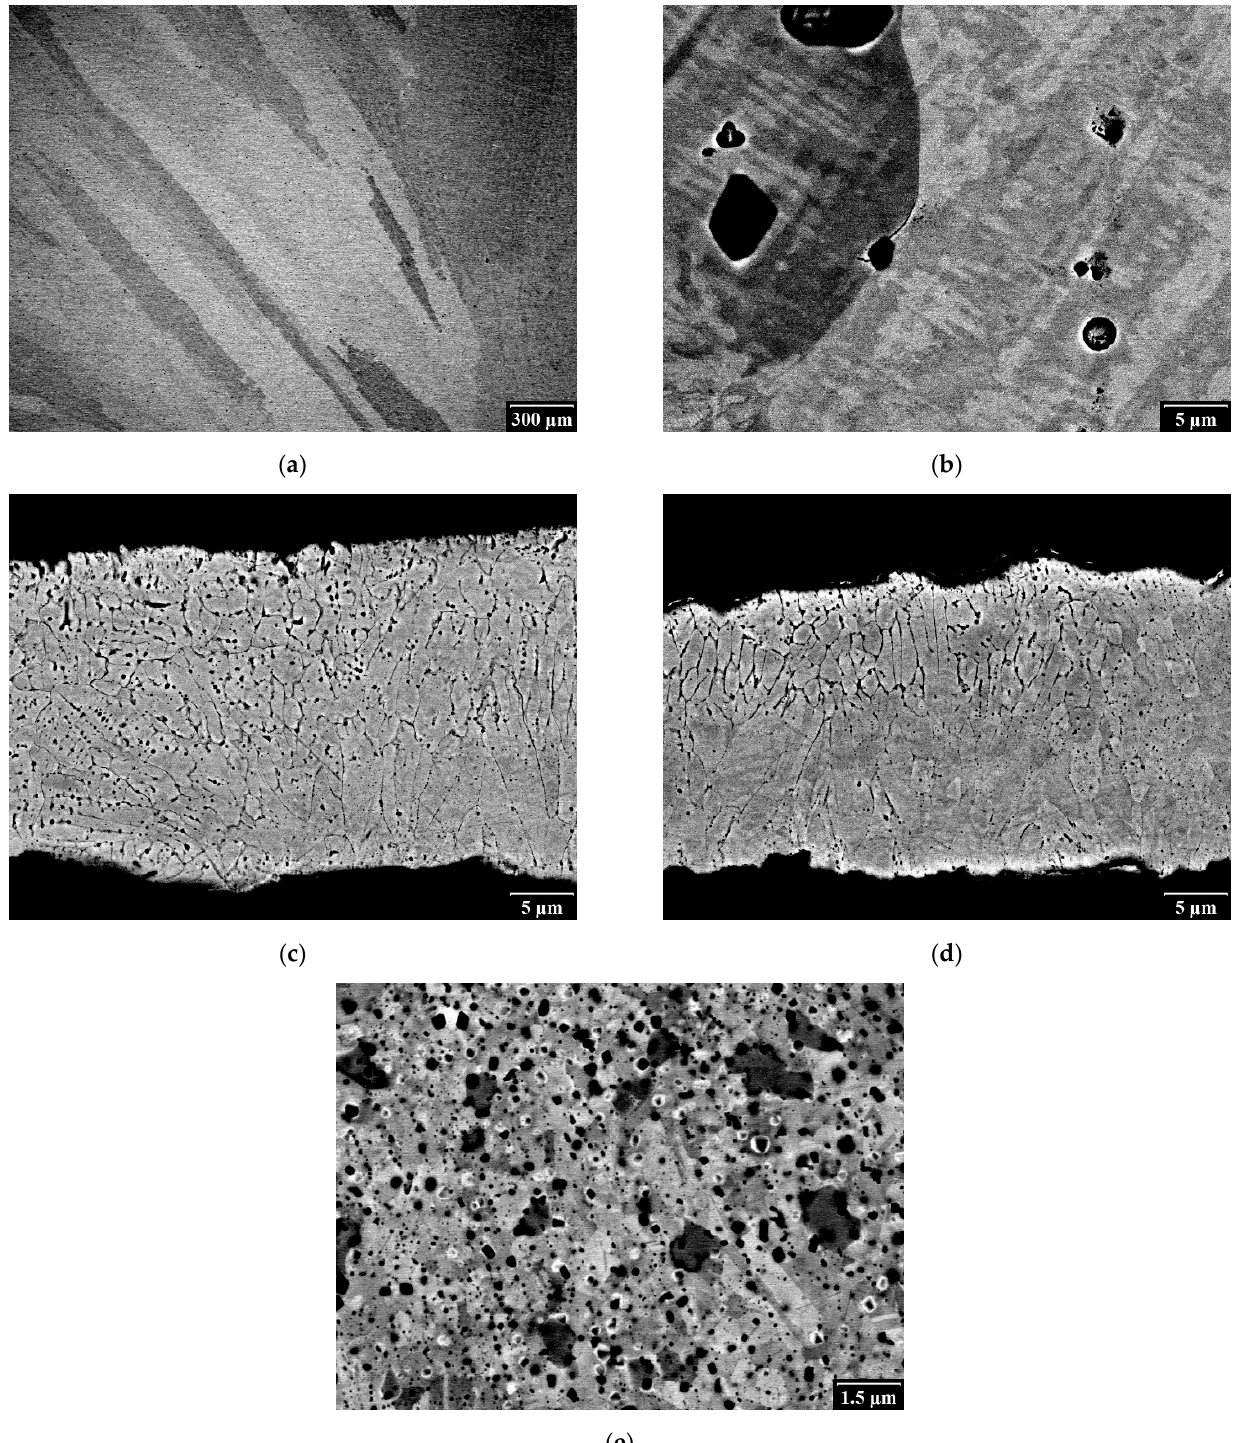
Figure 1. Microstructure of CoCrFeMnNi samples: ( a,b ) cast; ( c ) MS-water; ( d ) MS-air; ( e ) SPS. The thickness of the melt-spun ribbons varied between 15 and 60 µm, with the average thickness around 30 µm. The droplets of the material were occasionally observed. The solidification started on the side adjacent to the cooling wheel (bottom side of Figure 1c,d) and the grains had a columnar shape. The grains were significantly smaller than in the case of the cast sample, which is characteristic of the melt-spinning process. Their size,